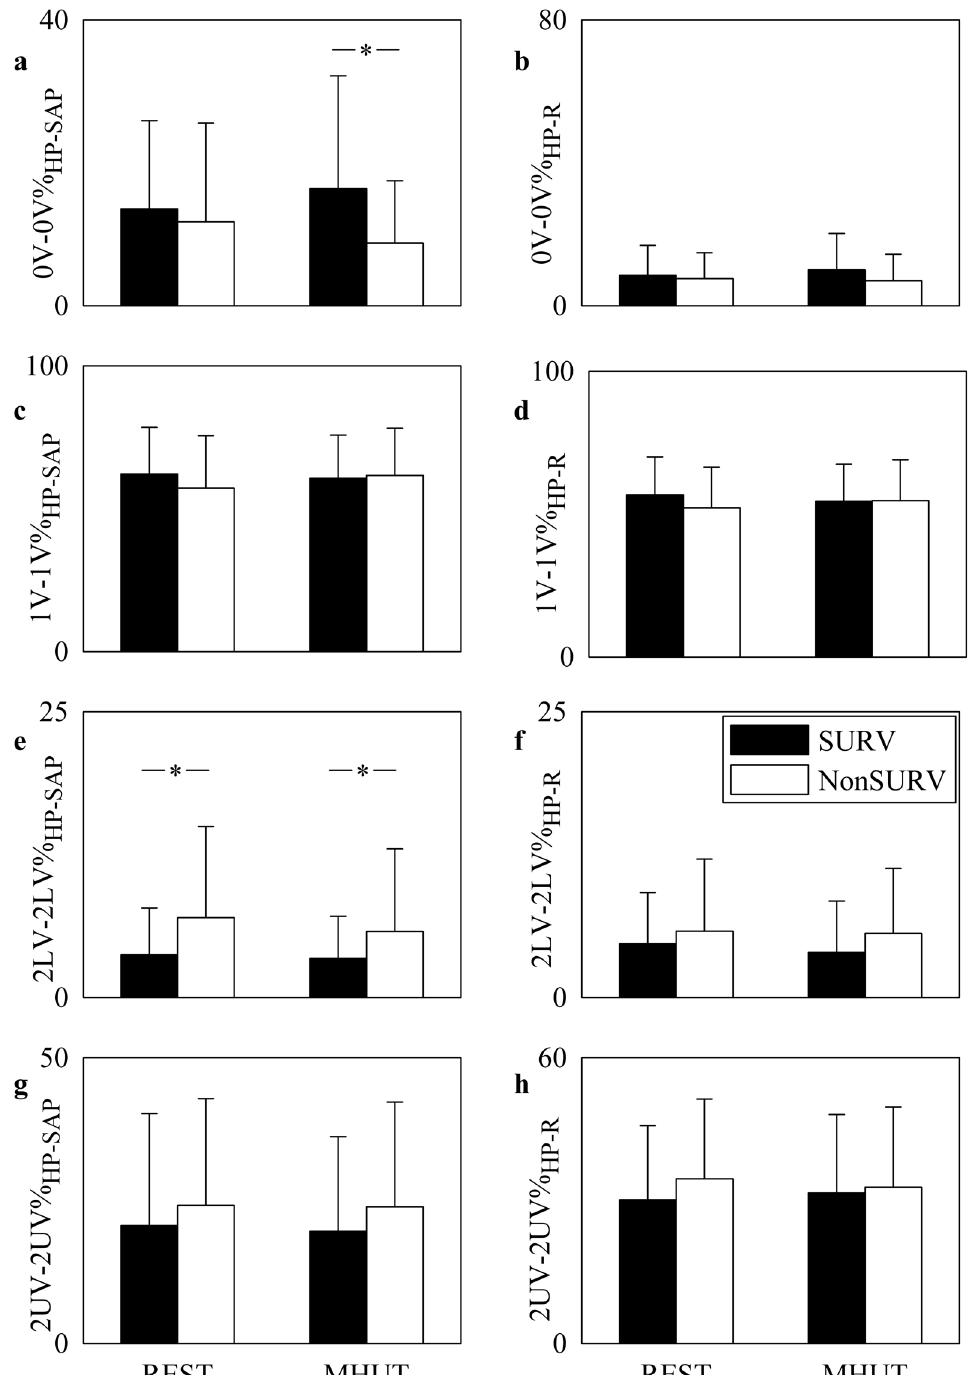
Figure 5. The bar graphs show 0V-0V% ( a , b ), 1V-1V% ( c , d ), 2LV-2LV% ( e , f ) and 2UV-2UV%( g , h ) computed to typify the dynamical interactions between HP and SAP series (a,c,e,g) and between HP and R ( b , d , f , h ) as a function of the experimental condition (i.e. REST and MHUT) in SURVs (dark bar) and NonSURVs (white bar). Data are reported as mean plus standard deviation. The symbol * indicates p <